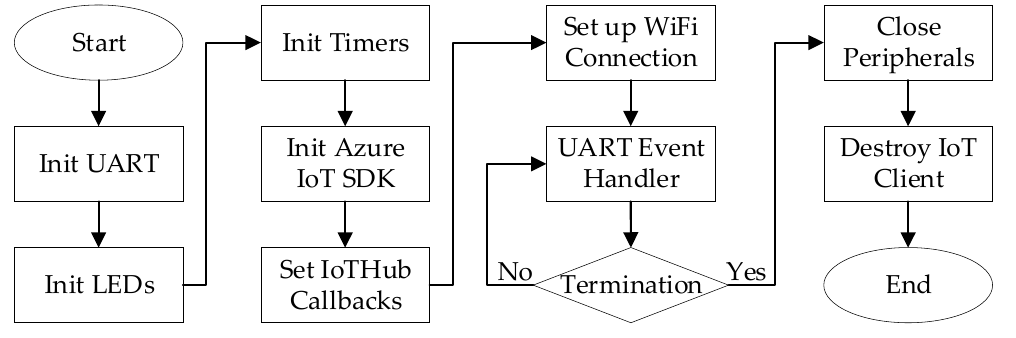
Figure 6. The flowchart of the application.